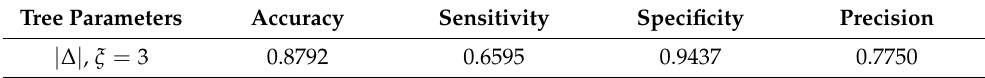
Figure 6. Decision tree and confusion matrix for metric | ∆ | , using w h = 1, w g = 1.5 and ξ = 3. Table 8. Performance of the best classification tree ( w h = 1, w g =